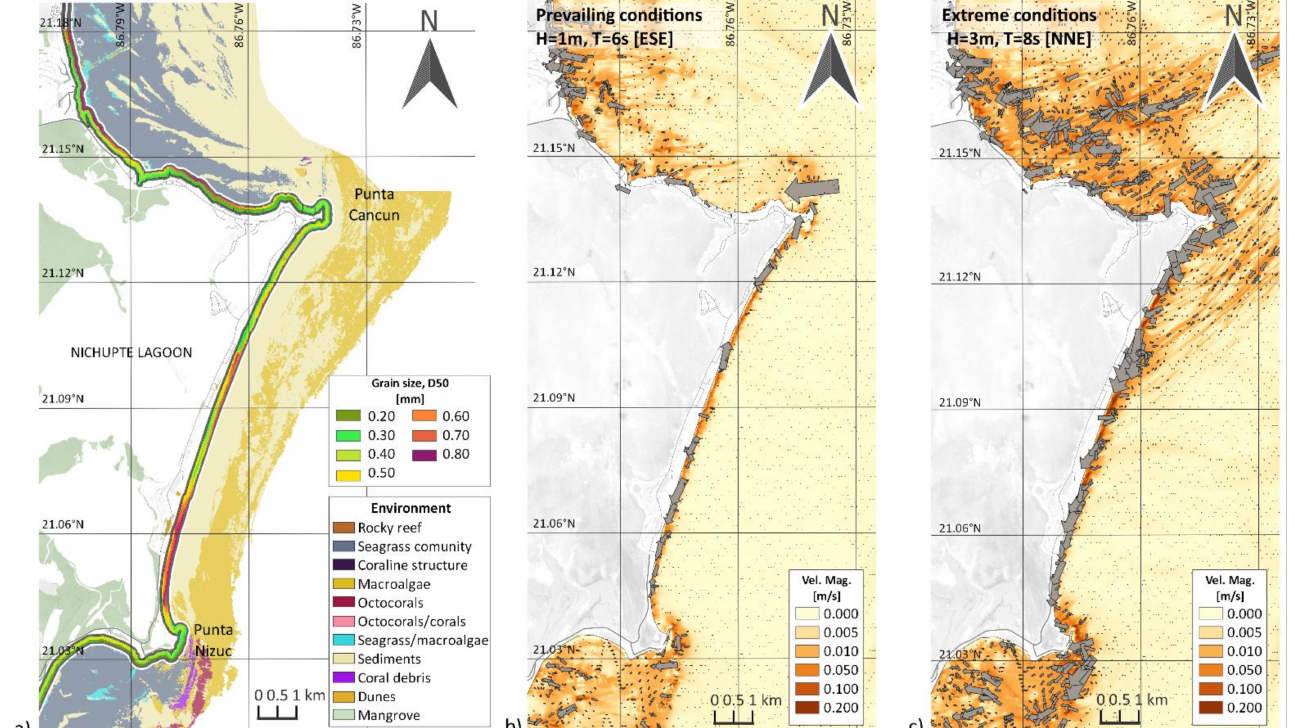
Figure 5. Results for Cancun showing ( a ) land use and variation of the sediment grain size (D 50 ). Sediment grain size variation is shown for a 150 m width strip along the shoreline, with sand samples from the backshore, nearshore and foreshore zones. Speed and direction of wave-induced currents are also shown for ( b ) prevailing [HS = 1 m, TP = 6 s, θ = 112.5 ◦ (ESE)] and ( c ) extreme conditions [HS = 3 m, TP = 8 s, θ = 22.5 ◦